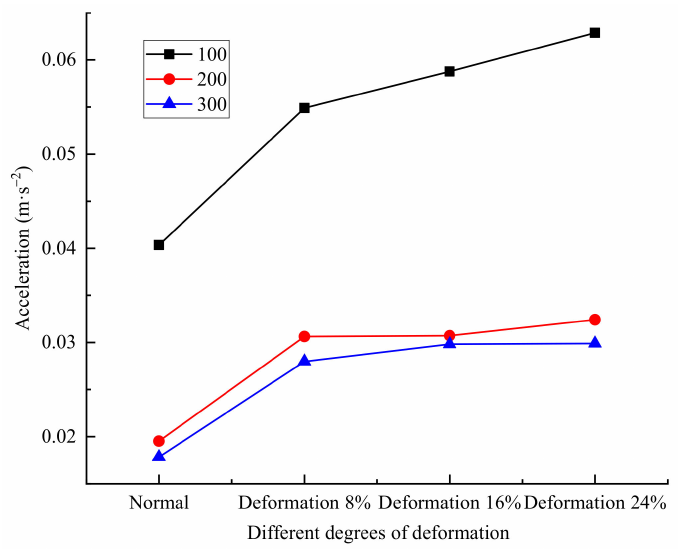
Figure 14. Amplitude change of the deformation acceleration at different degrees at the first 300